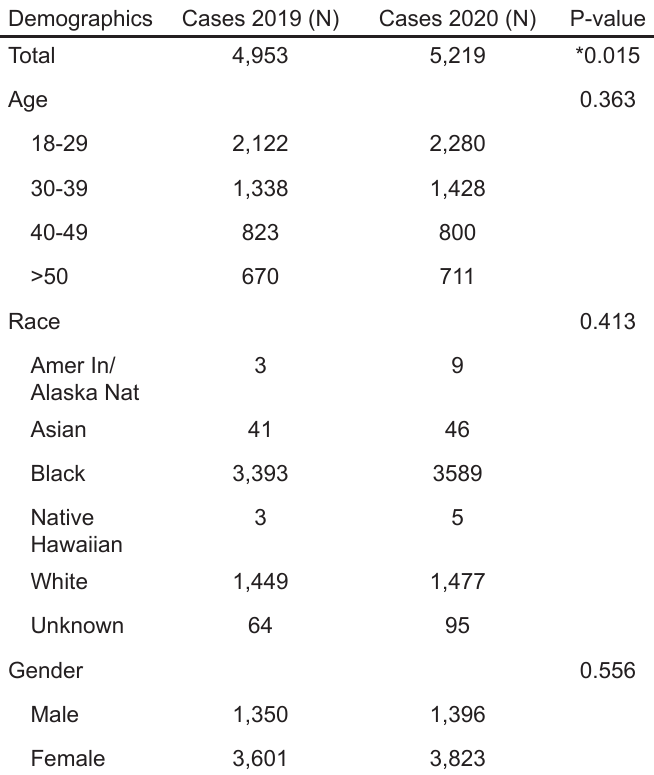
Table 1. Charlotte-Mecklenburg Police Department demographic data for all encounters categorized as intimate partner violence- related assaults from